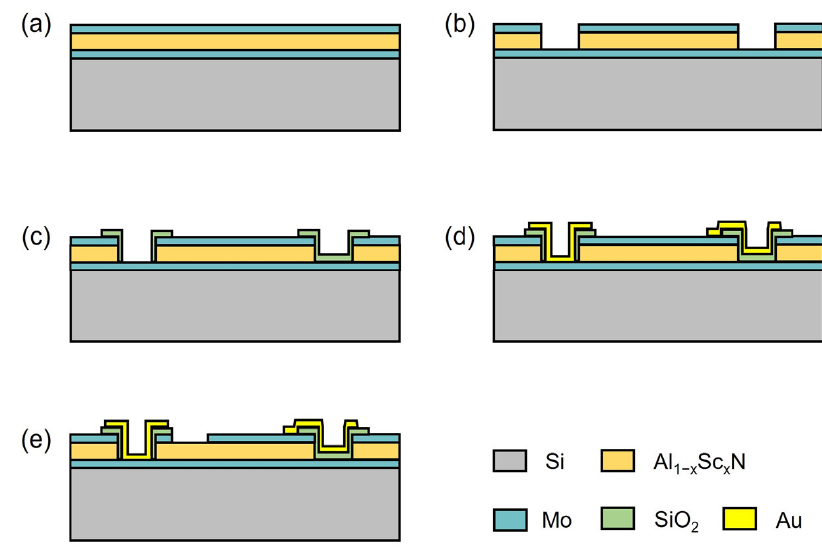
Figure 3. The fabrication process of Al 1 − x Sc x N HBAR devices. ( a ) Mo/Al 1 − x Sc x N/Mo piezoelectric stack deposition, ( b ) Top Mo/Al 1 − x Sc x N patterning, ( c ) SiO 2 isolation layer deposition and patterning, ( d ) Au contact layer deposition and patterning, ( e ) Top electrode Mo patterning.